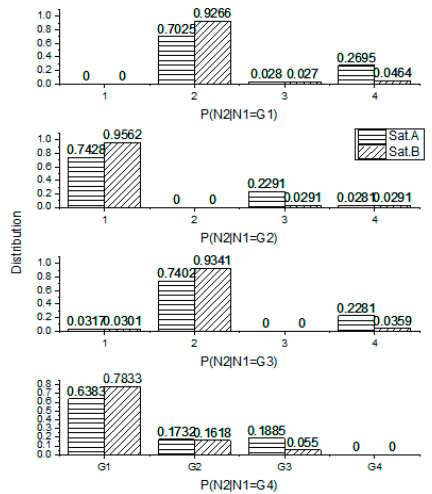
Figure 13. Failure PDF of Sat. A and Sat. B.